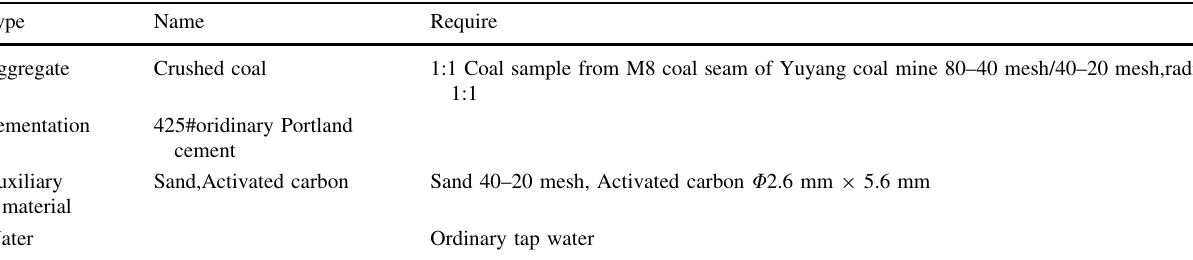
Table 1 Coal-like material and composition